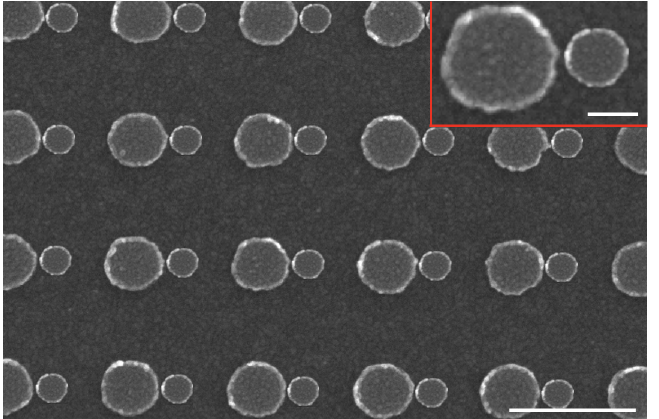
Figure 3. SEM picture of the hybrid asymmetric dimer array (scale bar = 300 nm). The inset corresponds to the zoom of an asymmetric dimer (scale bar = 50